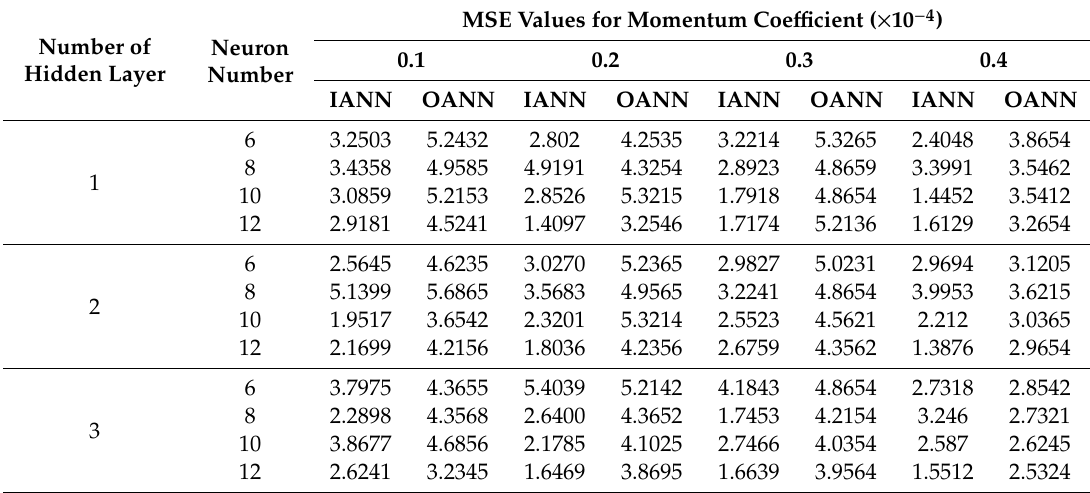
Table 6. The variation of mean squared error (MSE) values with di ff erent ANN configurations.